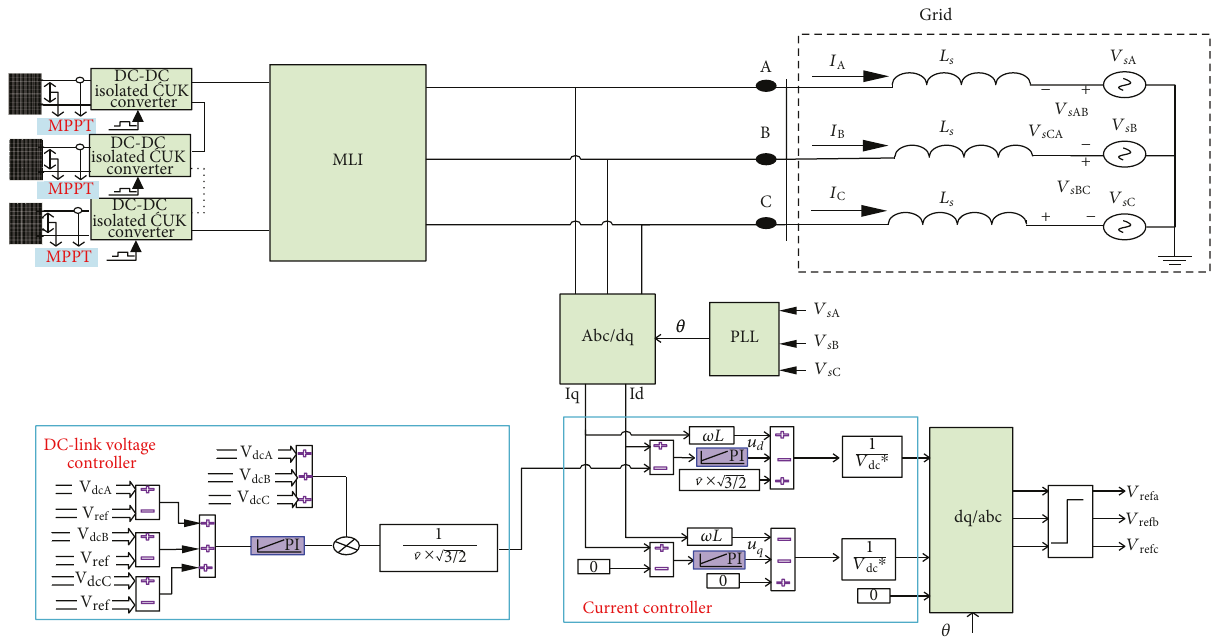
Figure 6: The proposed control strategy of three-phase cascaded VSI are used to simulate the proposed system depicted in Figure 3, with a reference DC-link voltage of 150 V. The generated seven-level line-line voltage is illustrated in Figure 8(a). The three-phase grid voltages and the grid cur- rents are in phase, as can be seen in Figure 8(b).